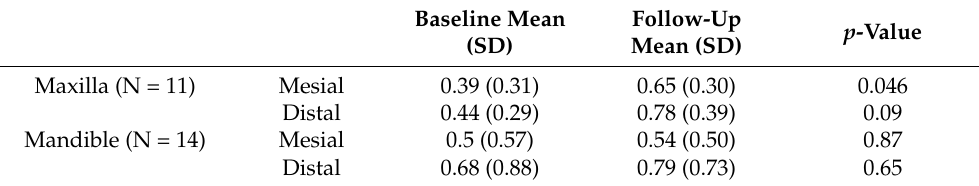
Table 3. Bone levels according to site location.